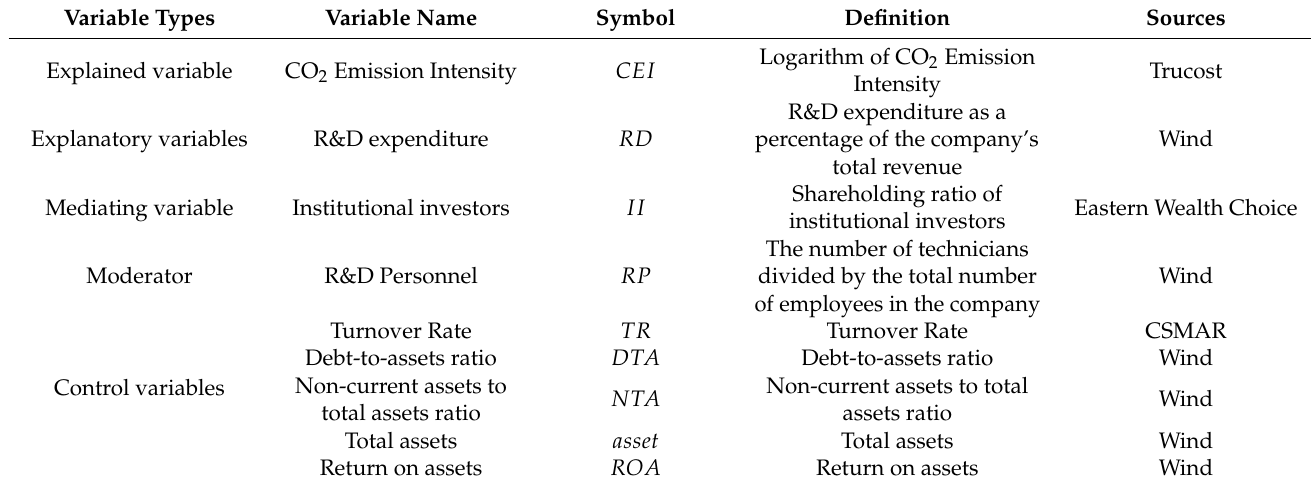
Table 1. Variable definition and